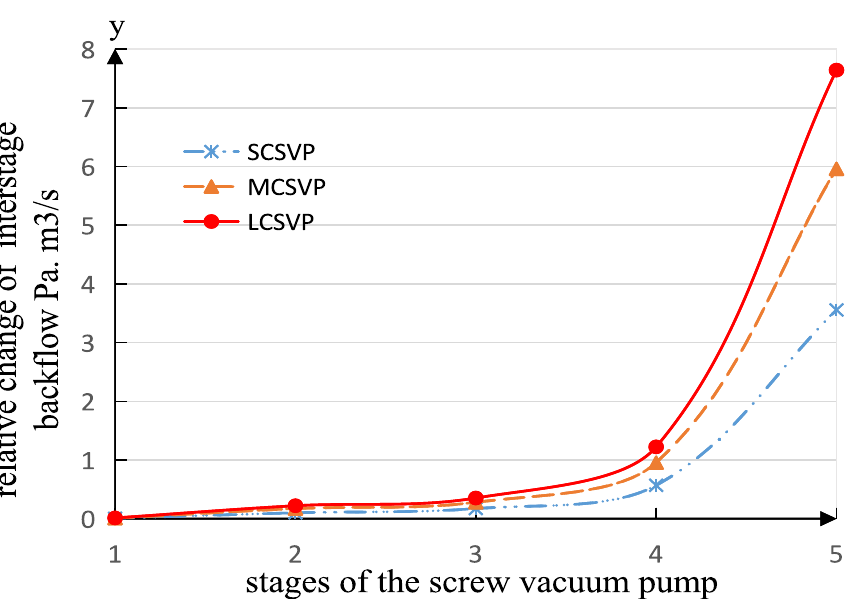
Fig. 22. Curves of interstage back fl ow increment with rotating